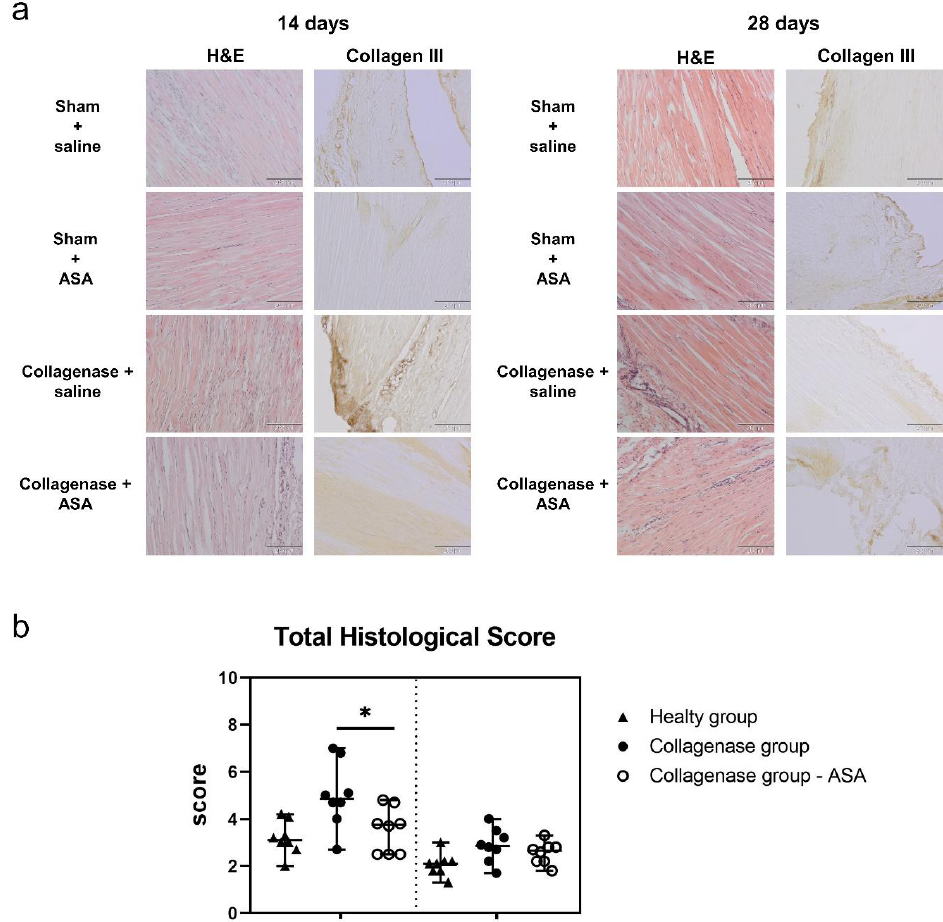
Figure 3. Histological analysis for the treated groups. ( a ) Hematoxylin & Eosin (H&E) staining and Collagen III immunohistochemical (IHC) staining of the sham / saline, sham / amniotic suspension allograft (ASA), collagenase / saline, and collagenase / ASA groups at 14 days and 28 days post-treatment. Scale bar indicates 200 µ m. ( b ) Total histological score for tendons in the Healthy group, the Collagenase group and the Collagenase group – ASA at 14 and 28 days post-treatment. Median with range reported. * denotes p < 0.05 by Mann-Whitney U test.